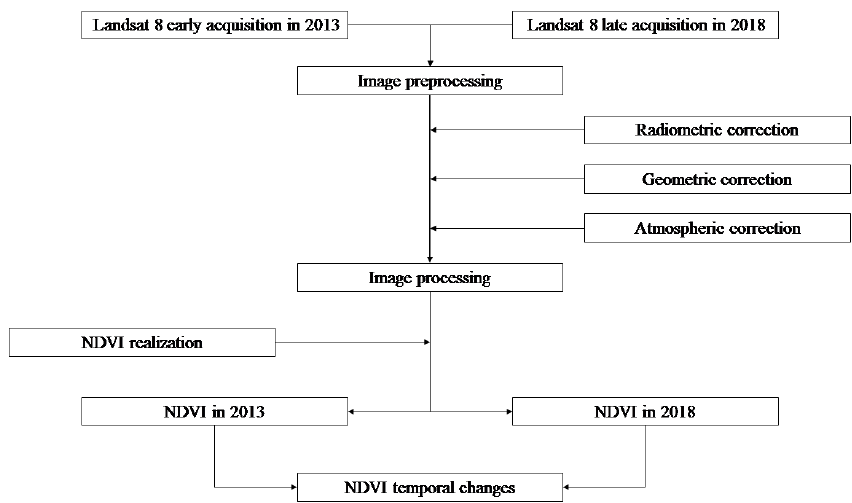
Figure 3. Methodological flowchart of remote sensing data analysis.